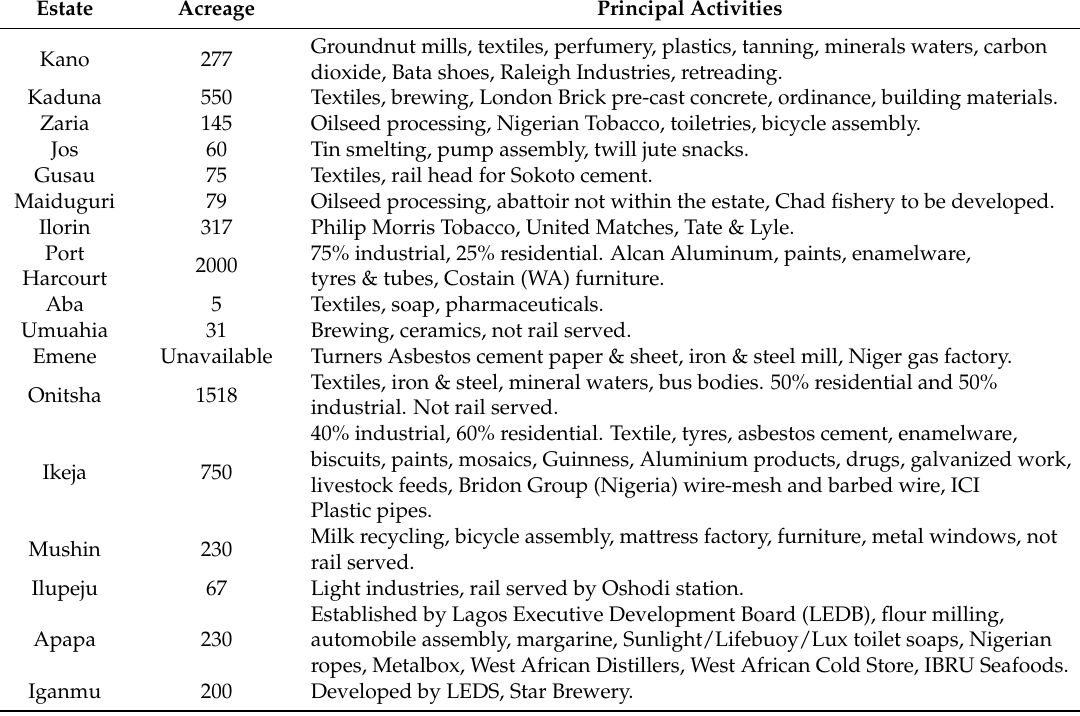
Table 4. Industrial estates in Nigeria and their principal activities in 1971 (Source: archives of the Nigerian Railway Corporation,